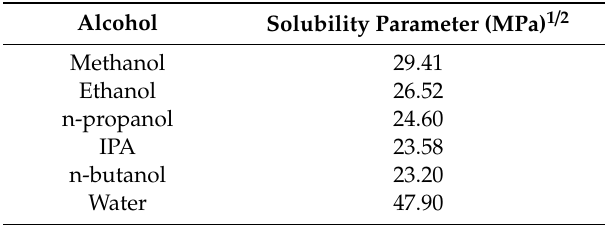
Table 2. Reported in [34] solubility parameters for each short chain